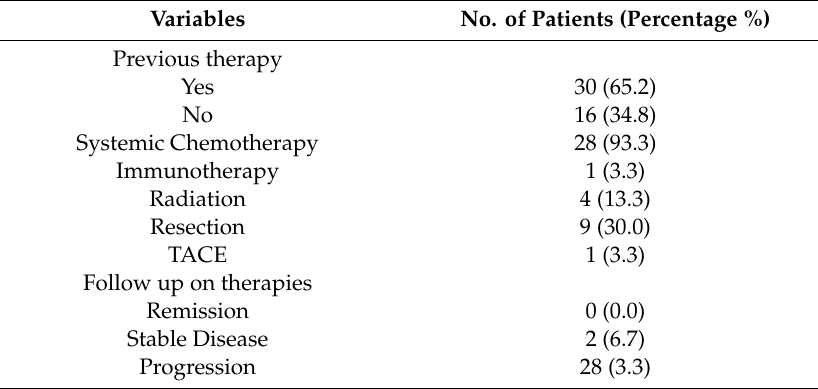
Table 2. Locoregional and systemic therapies.